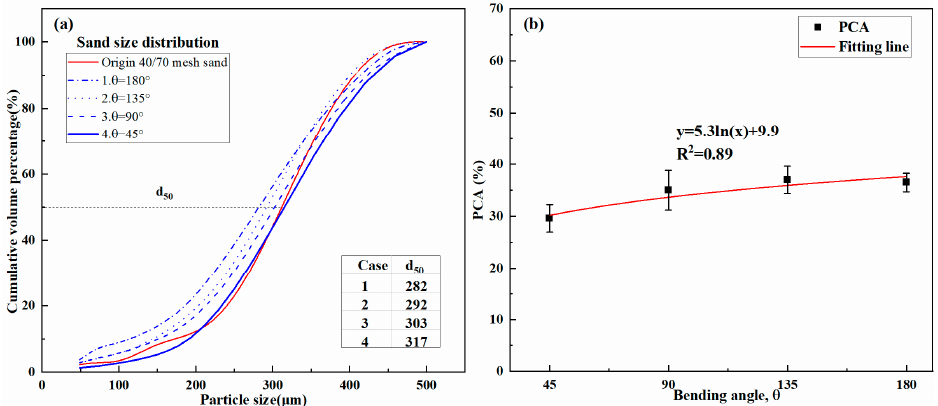
Figure 8. Effect of the bending angle on the particle dune distribution: ( a ) The particle size distribu- tions of sands flowed out the channel at the injection time = 180 s; ( b ) The PCA in four channels with different bending angles.